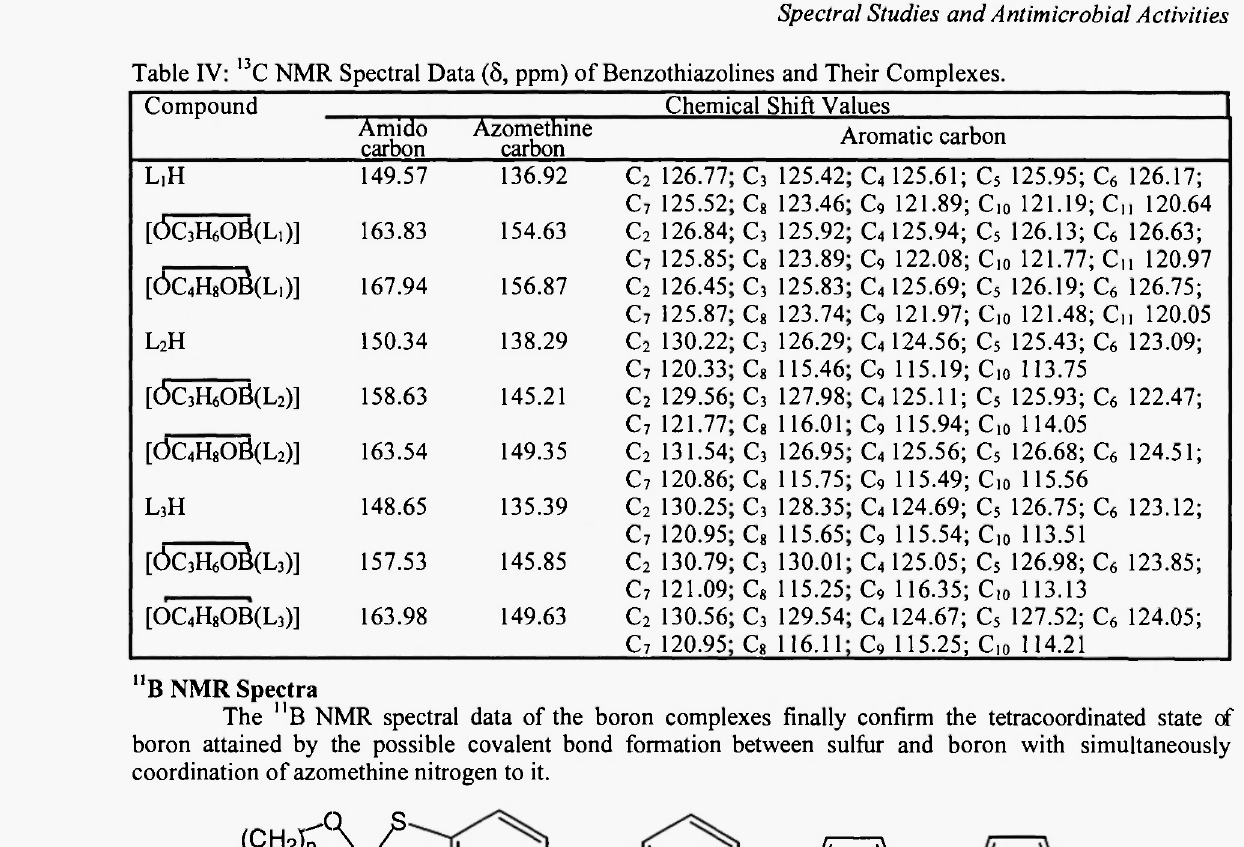
Table V: X-Ray Powder Diffraction of [OCjHeOB^)] Peak